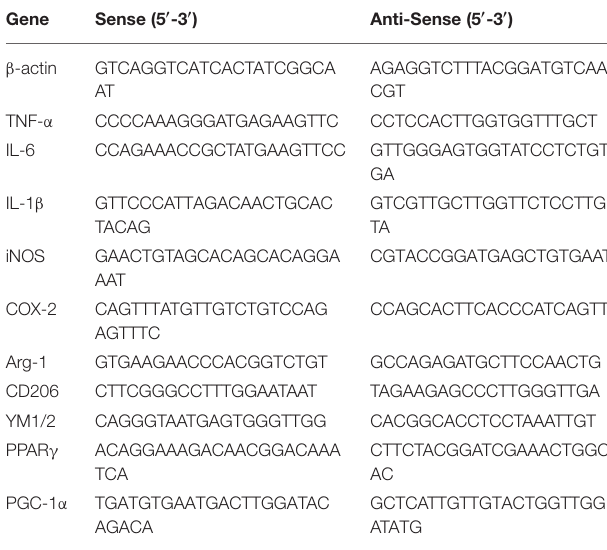
TABLE 1 | Primers for real-time